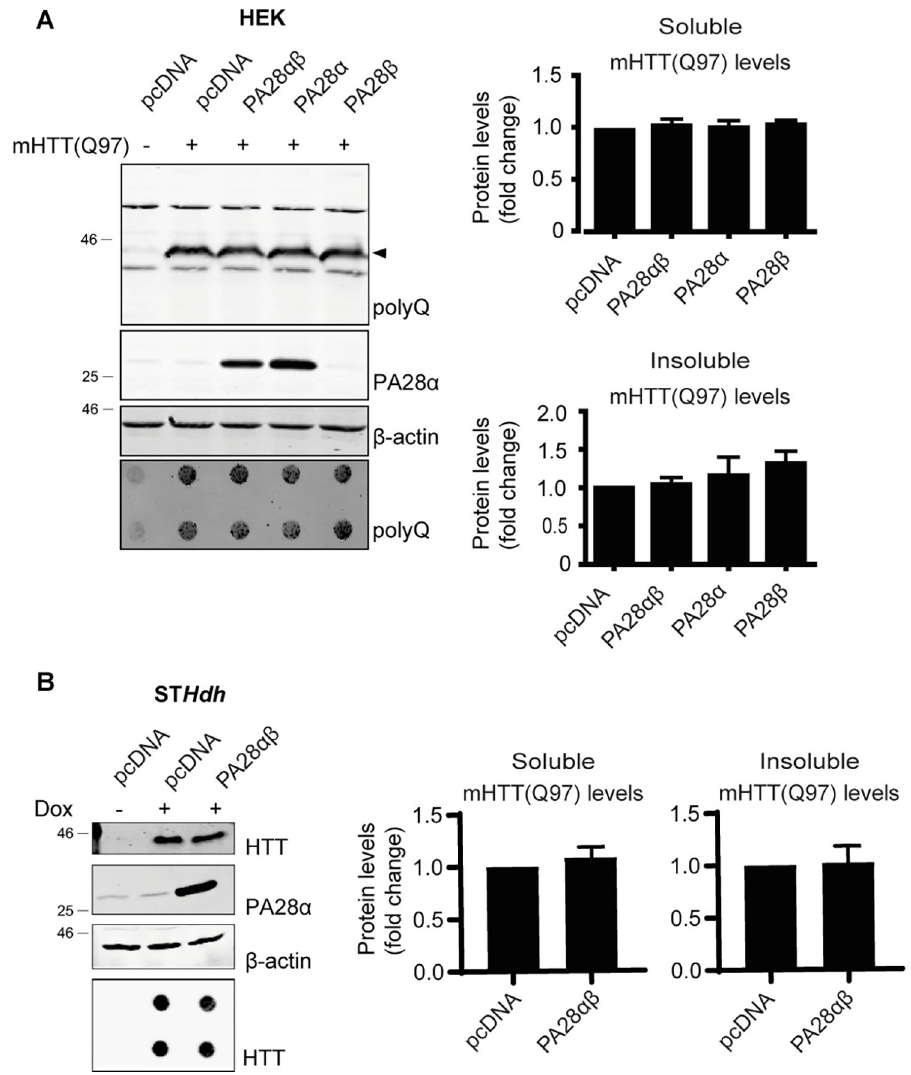
Fig 4. PA28 αβ overexpression does not affect mHTT degradation in cells. (A) Effects of PA28 α , PA28 β or PA28 αβ on levels of soluble (arrowhead) and insoluble mHTT(Q97) in HEK293 cells. Data are normalized to pcDNA transfected cells and shown as mean ± SEM (n = 3). One-way ANOVA with Dunnet’s multiple testing; for soluble mHTT PA28 αβ p = 0.8481, PA28 α p = 0.9552, PA28 β p = 0.7517; for insoluble mHTT PA28 αβ p = 0.9900, PA28 α p = 0.7822, PA28 β p = 0.3380 (B) Effects of PA28 αβ on soluble and insoluble mHTT(Q97) in ST Hdh cells expressing dox inducible mHTT(Q97)exon1. Data are normalized to pcDNA transfected cells and shown as mean ± SEM (n = 4). One sample t-test; for soluble mHTT p = 0.47; for insoluble mHTT p = 0.82.